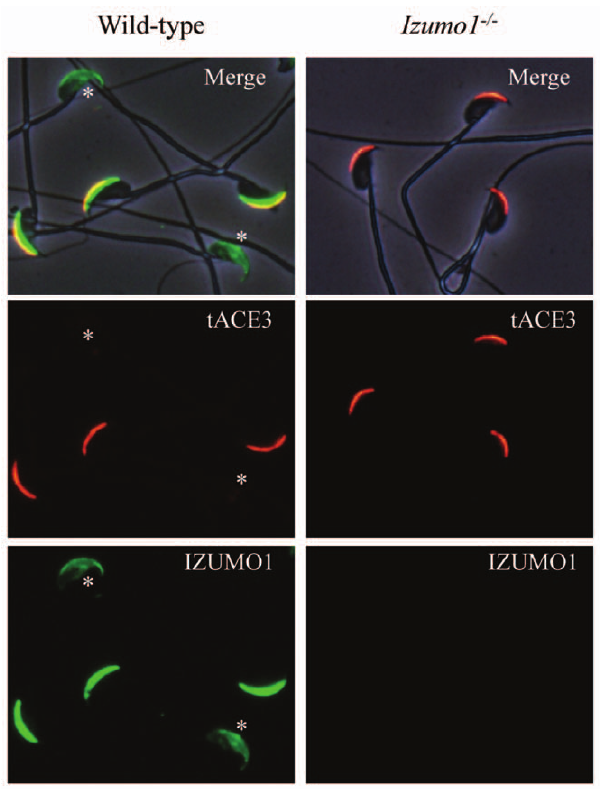
Figure 2. Subcellular localization of tACE3 protein in mature sperm. Incubated sperm (left) and Izumo1 knockout sperm (right)